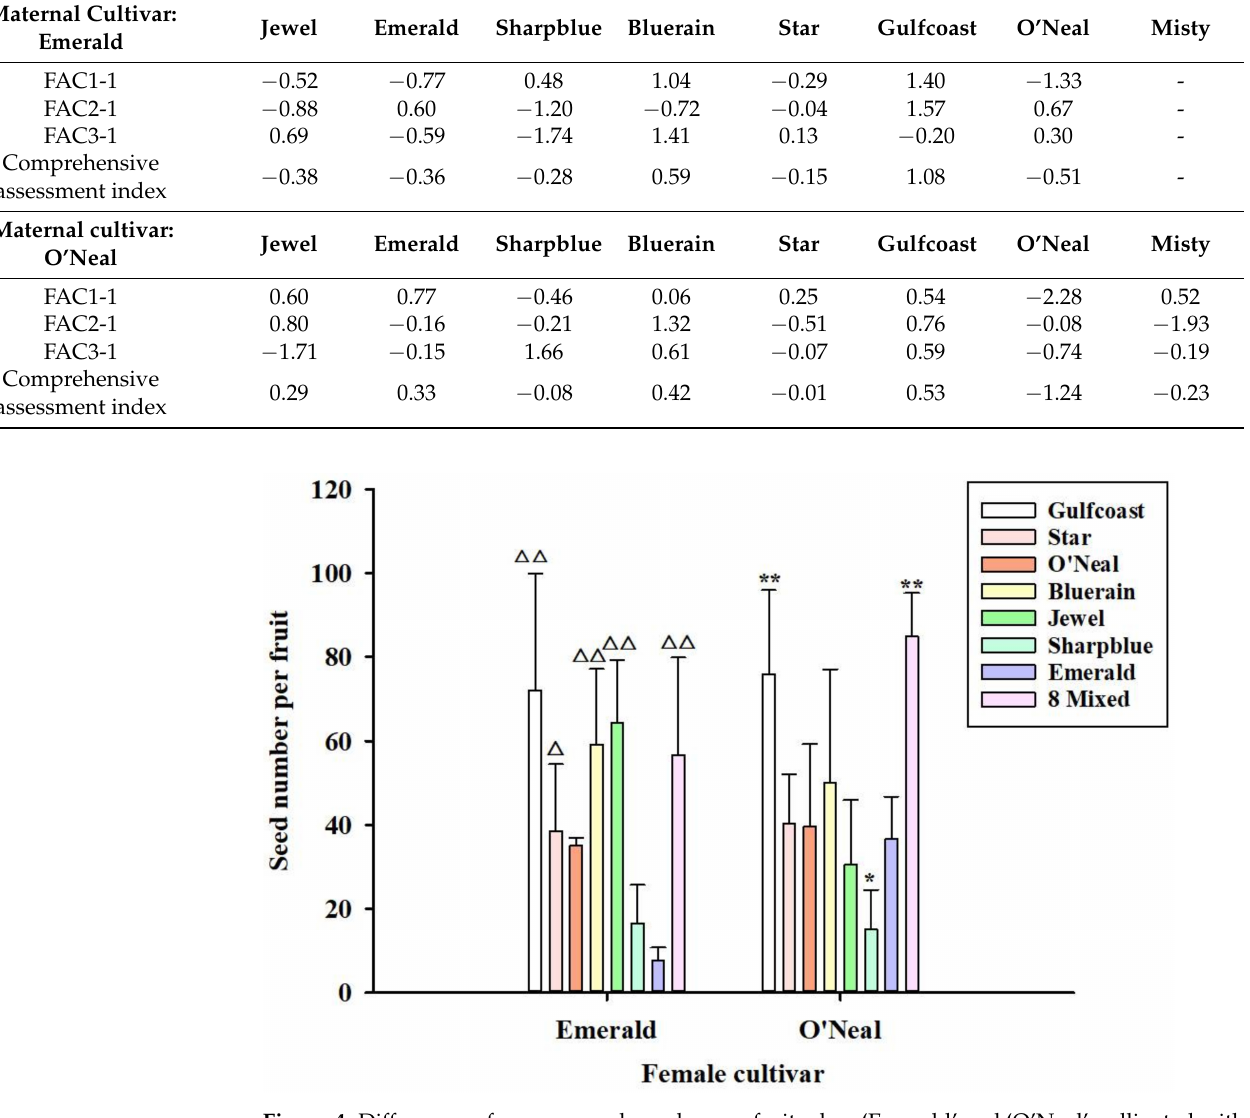
Figure 4. Differences of average seed number per fruit when ‘Emerald’ and ‘O’Neal’ pollinated